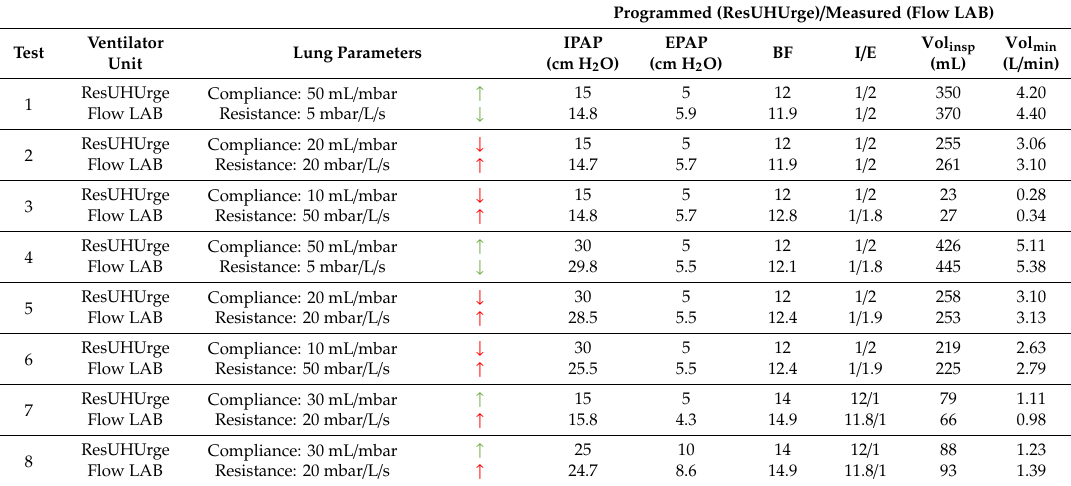
Table 3. ResUHUrge and Flow LAB ventilation parameters for di ff erent simulation